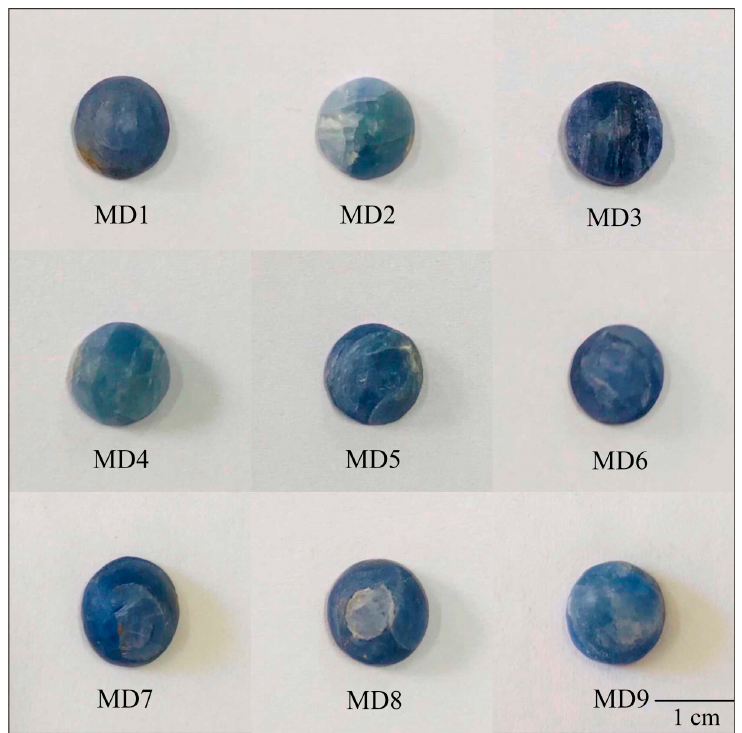
Figure 3. Cutting samples of sapphires from the Baw-mar mine.